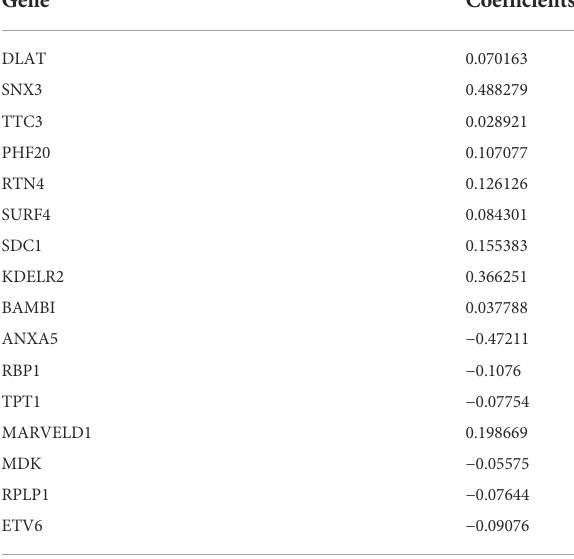
TABLE 1 Genes used for model building and their Coef fi